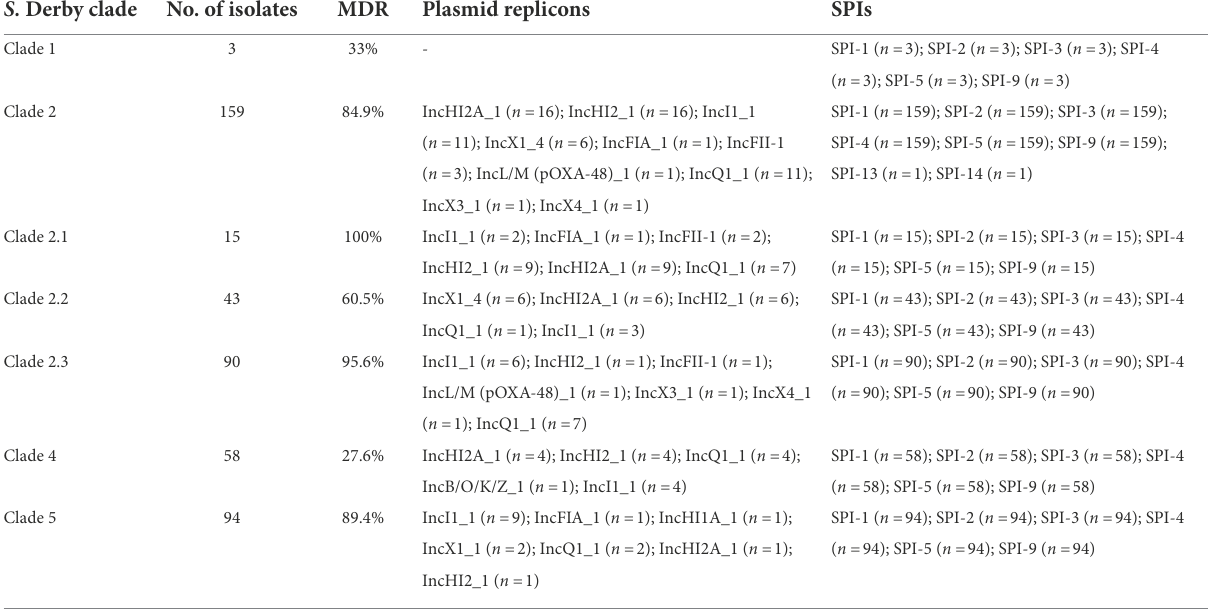
TABLE 1 Results of plasmid replicon and virulence gene analysis of Salmonella Derby ST40 strains ( n = 314). S. Derby